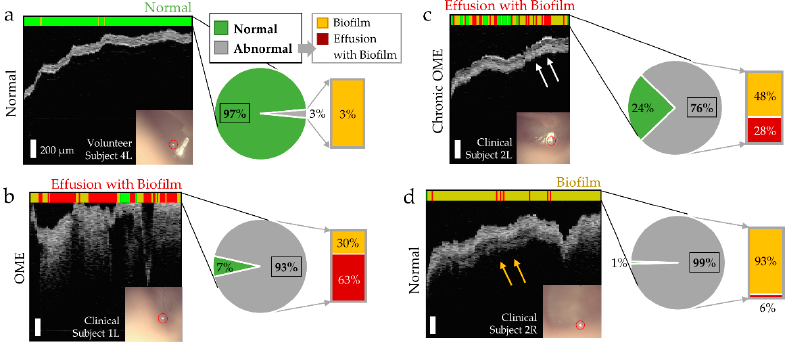
Figure 6. ML-briefcase OCT measurements from subjects clinically diagnosed with OM. ( a ) Representative results from a normal middle ear for comparison; ( b ) results from a subject diagnosed with OME, where most regions were classified as ‘Abnormal’ (containing effusion with biofilm); ( c ) results from a subject in which her left ear was diagnosed with chronic OME, and OCT detected additional structures behind the TM (white arrows); ( d ) results of the right ear from the same subject as in ( c ), and the additional structures are visualized (yellow arrows). However, note that this ear was clinically diagnosed with only an otoscope as being a normal middle ear. Red circles in ( a – d ) indicate the location and focus of the OCT beam. Note that only the left ear of Clinical Subject 2 was clinically diagnosed with OM, and the right ear was clinically diagnosed as normal, using a standard otoscope. However, OCT detected additional structures behind the TM (yellow arrows in Figure 6d) from the right ear of Clinical Subject 2. As a result, the right ear of Clinical Subject 2 was classified as ‘Abnormal’ and suggested that this ear contained a middle ear biofilm. This is not sur- prising considering that this subject’s left ear was diagnosed with chronic OME, and OM often occurs bilaterally in both ears. However, the ML classifier did not indicate that this ear contained an effusion, which agreed with physician diagnosis. The datasets shown in Figure 6a,c,d were collected by an Expert user, while the da- taset shown in Figure 6b was collected by the Novice user (research coordinator) who did not have any prior experience with OCT and otoscopy imaging. Even though three users with different levels of experience (researcher experienced in OCT ear imaging, ENT phy- sician and research coordinator) imaged three ears from the two clinical subjects, three classified results were obtained from one ear (Clinical Subject 2R) out of three ears. This was largely due the time constraints and the limited number of imaging attempts (1–3 attempts for each ear), which resulted in greater motion artifacts, flipped OCT images and low SNR. Nonetheless, Clinical Subject 2R was classified as ‘Abnormal with Biofilm only’ from all three users. 4. Discussion The adoption of telemedicine has gradually increased over the past decades in the United States [38] and particularly during the coronavirus (COVID-19) pandemic [39]. In otolaryngology, telemedicine may involve low-cost, compact, diagnostic devices or smartphones, which enable remote examination and monitoring of various diseases [40]. With continuous advances in AI techniques and big data, recent investigations have de- veloped AI-assisted imaging platforms for otoscopy to diagnose and monitor OM [41–43]. Several studies have shown that by using a ML approach on otoscopy images for detecting middle ear effusions, an overall accuracy of 84%–94% can be achieved [43–45], compared